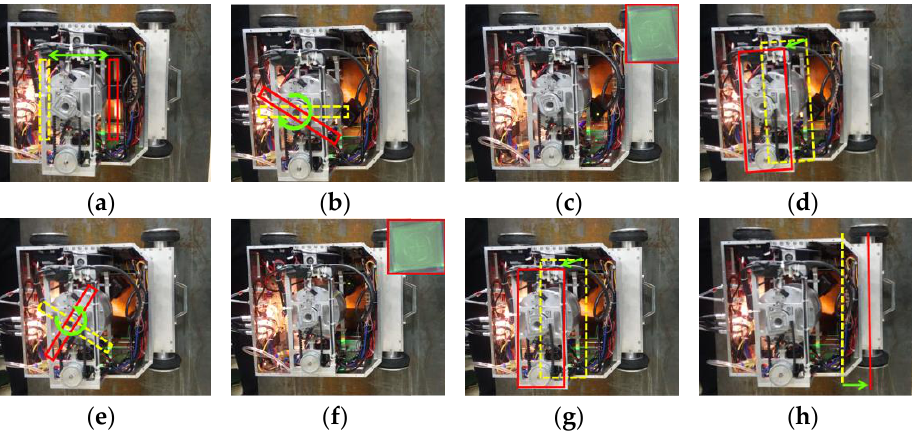
Figure 13. Automatic detection process. ( a ) Fluorescent magnetic suspension spraying; ( b ) the yoke turns right and goes down; ( c ) excitation and takes photos; ( d ) the yoke rises up; ( e ) the yoke turns left and goes down; ( f ) excitation and takes photos; ( g ) the yoke rises up to original height; ( h ) the robot goes ahead.